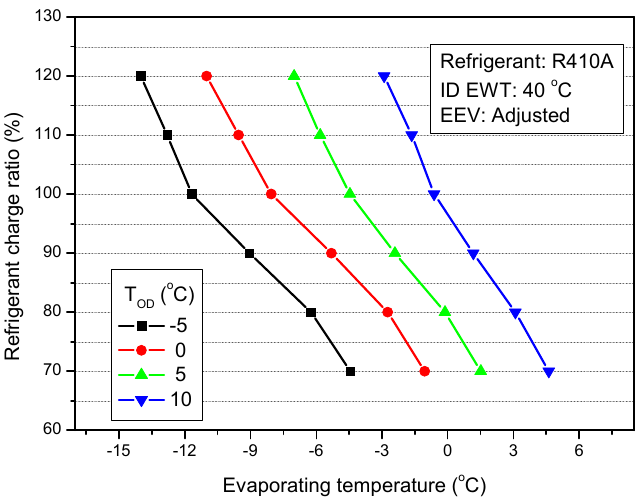
Figure 29. Relationship between refrigerant charge ratio and evaporating temperature in heating mode.